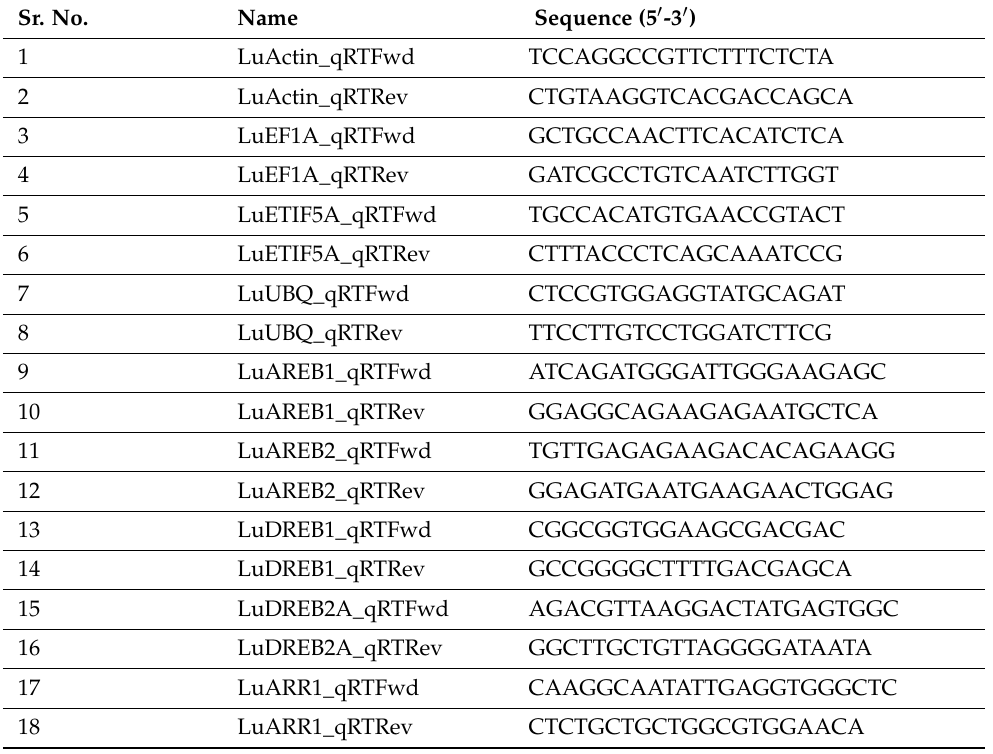
Table 2. List of primer pairs used for validation of reference genes (RGs) and drought-responsive genes (DRGs) in qRT-PCR expression analysis in